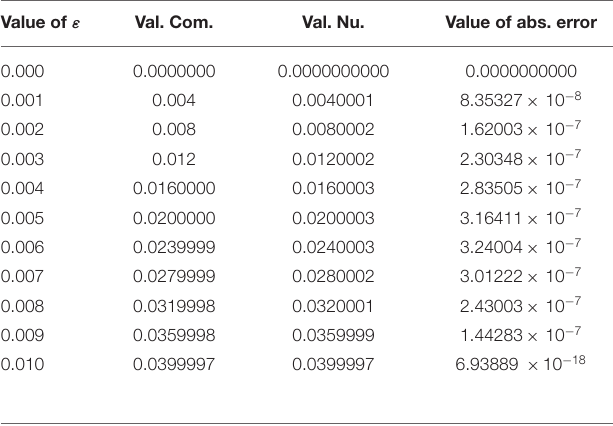
TABLE 2 | Computational, numerical, and absolute error values obtained by using the cubic B–spline scheme.